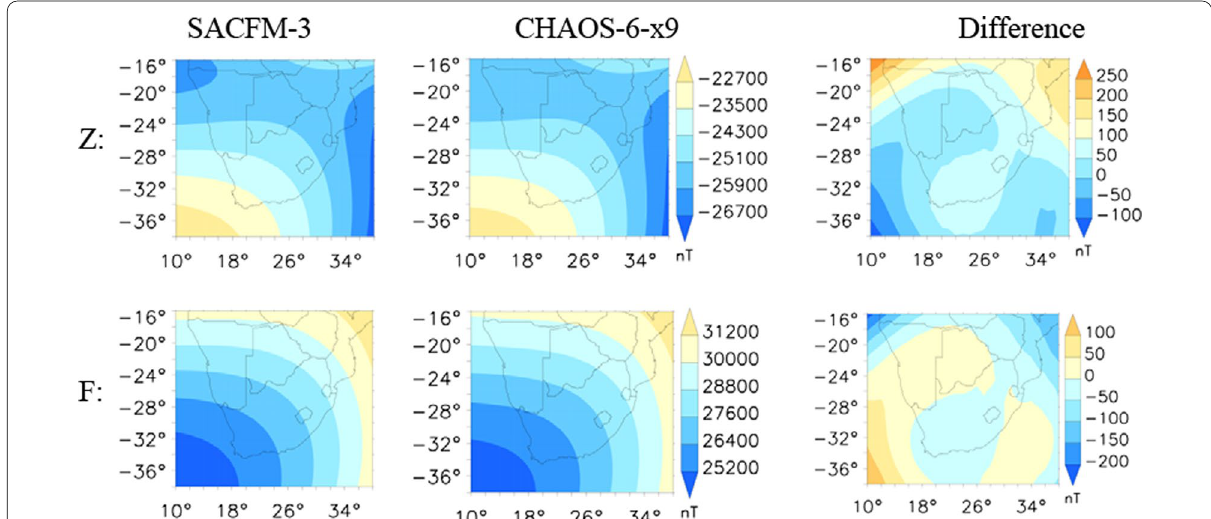
9 (second column) and their differences (third ×